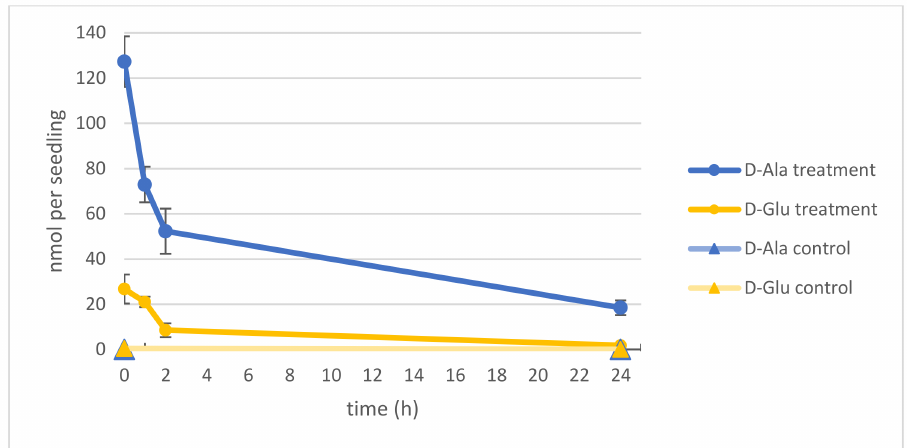
Figure 1. Decrease of D -Ala and D -Glu levels in Arabidopsis seedlings within 24 h. Dark blue lines represent the D -Ala and dark yellow lines the D -Glu contents of seedlings, respectively. Measurements from D -amino acid (AA)-treated plants are marked with circles; untreated control plants with lighter colors and triangles. The measurements started directly at transfer to fresh media up to 24 h later. Error bars: ± SD.